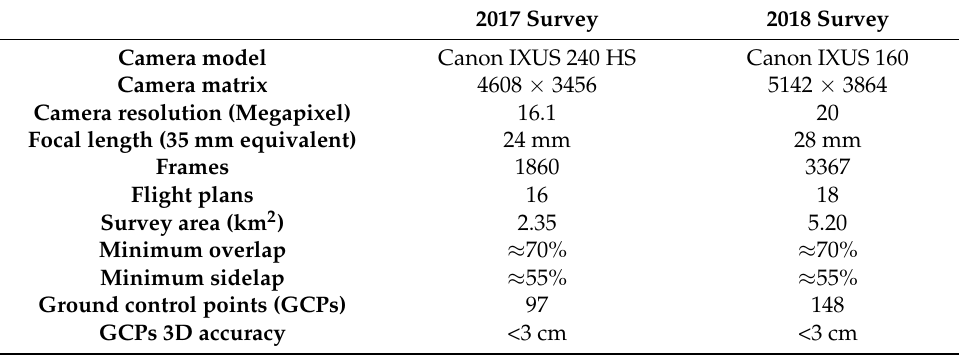
Table 1. Characteristics of the UAV photogrammetric